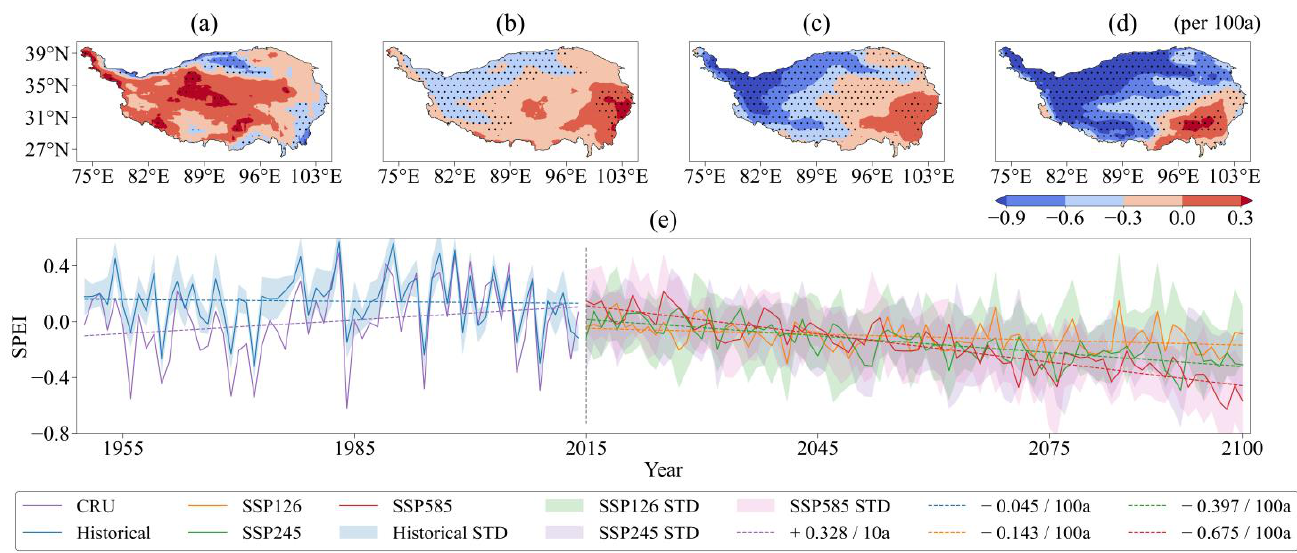
Figure 13. Trend test results of SPEI for the HQ-corrected ensemble model. ( a – d ) represent the spatial trend of SPEI in the historical and future scenarios, respectively. The black dots are significant points with p < 0.05. ( e ) represents the change curve of the SPEI of the ensemble model in the historical and future scenarios. The filling on both sides of the line represents the respective standard deviation, and the dashed line is the trend line.